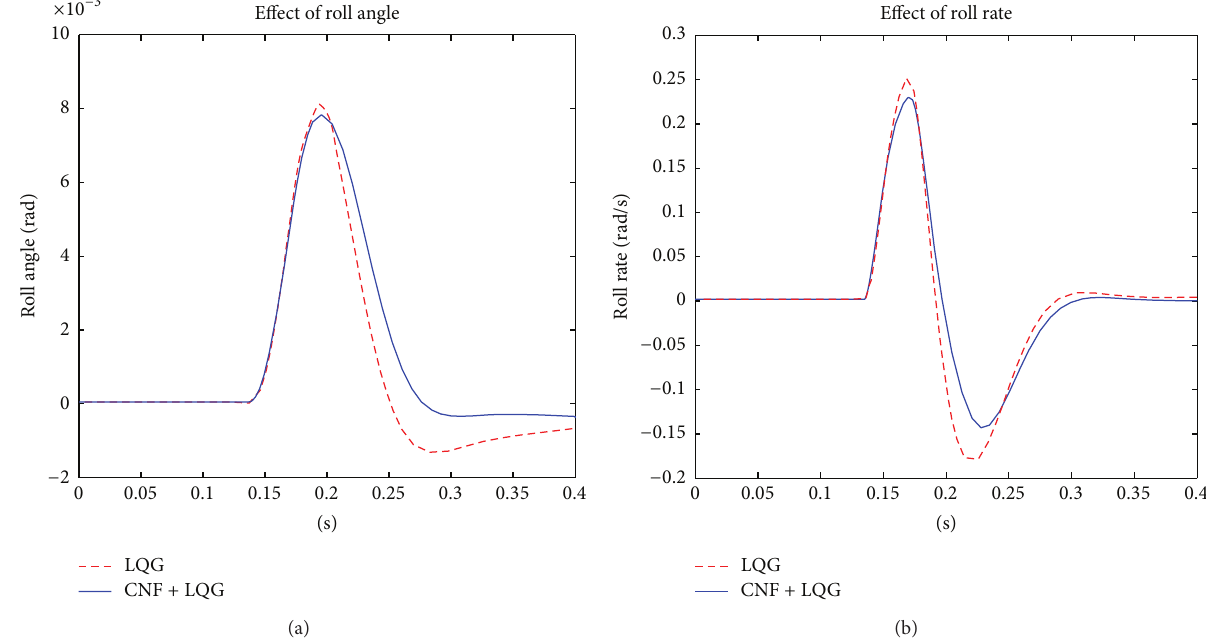
Figure 9: Speed bump test (a) roll angle response and (b) roll rate